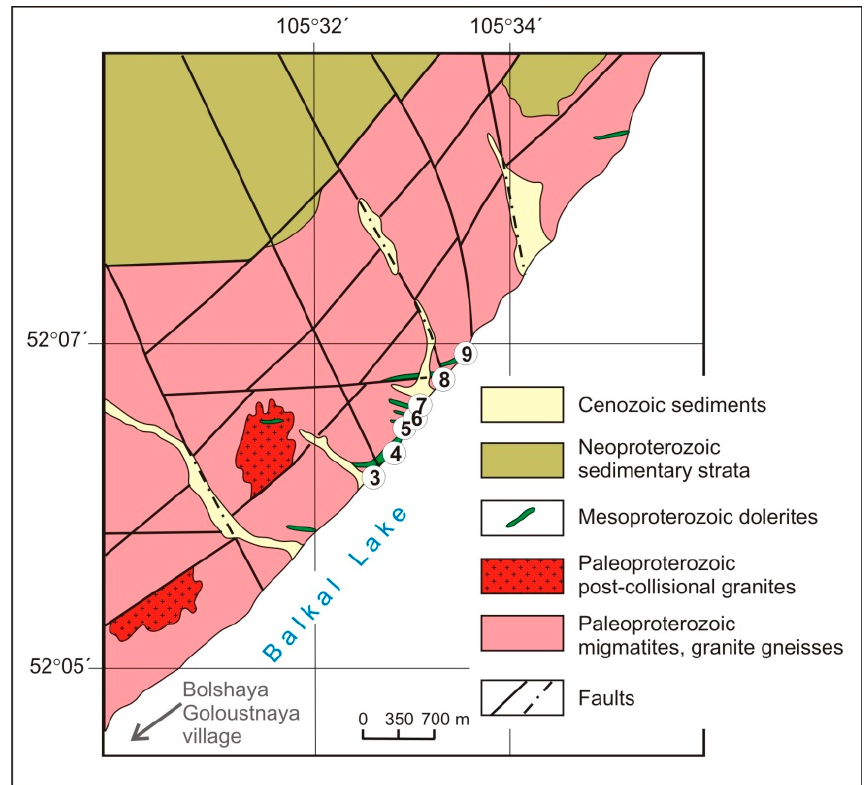
Figure 3. Photomicrographs of Listvyanka and Goloustnaya dolerites: ( a ) sample 14101 of Listvyanka dolerite and ( b ) sample 1265 of Goloustnaya dolerite. Mineral abbreviations: Amp, amphibole; Cpx, clinopyroxene; Opx, orthopyroxene; Pl, plagioclase; Bt, biotite; Qz, quartz.